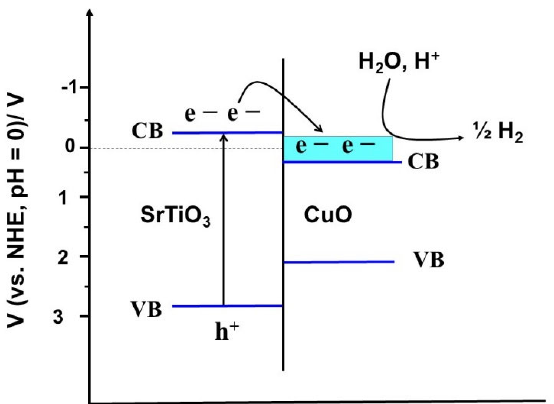
Figure 12. Schematic diagram of the energy band positions of SrTiO 3 , CuO and the direction of electron transfer.